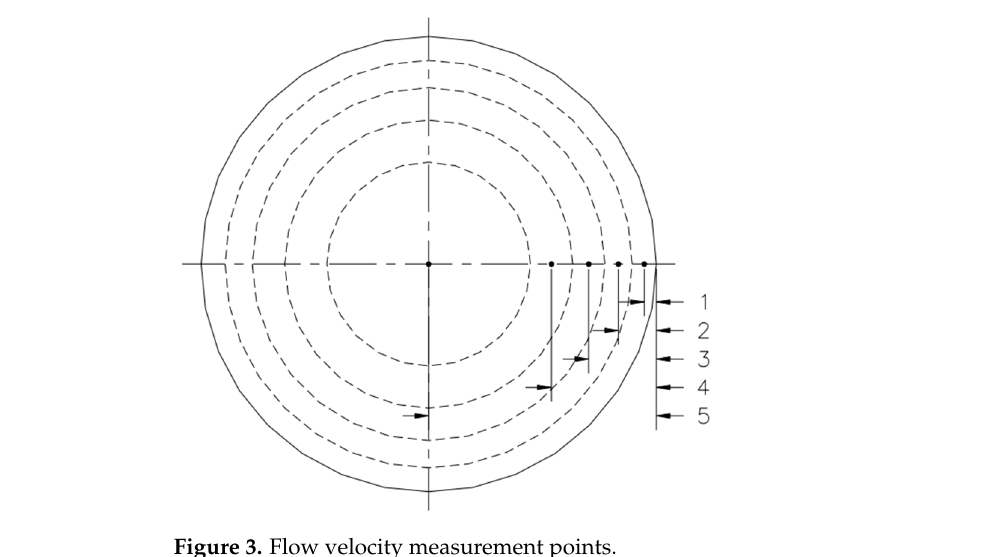
Figure 3. Flow velocity measurement points. Table 2. Insertion length of air velocity transducer.